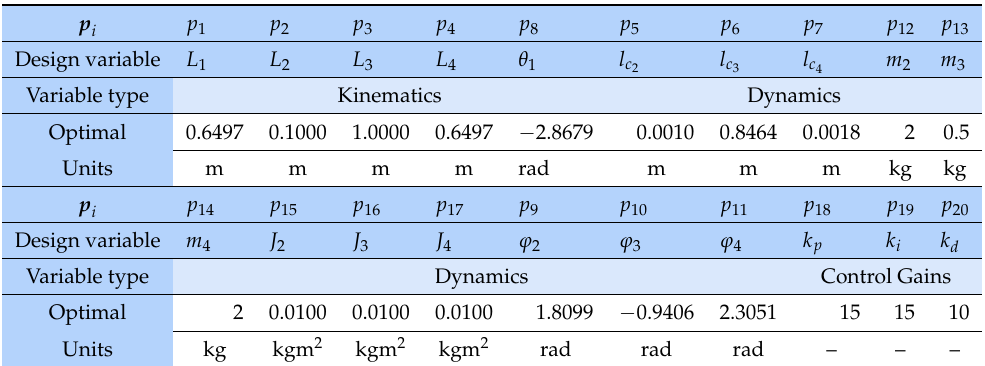
Table 3. Numerical values of design parameters for an optimal solution for the case of study in Figure 7 and Table